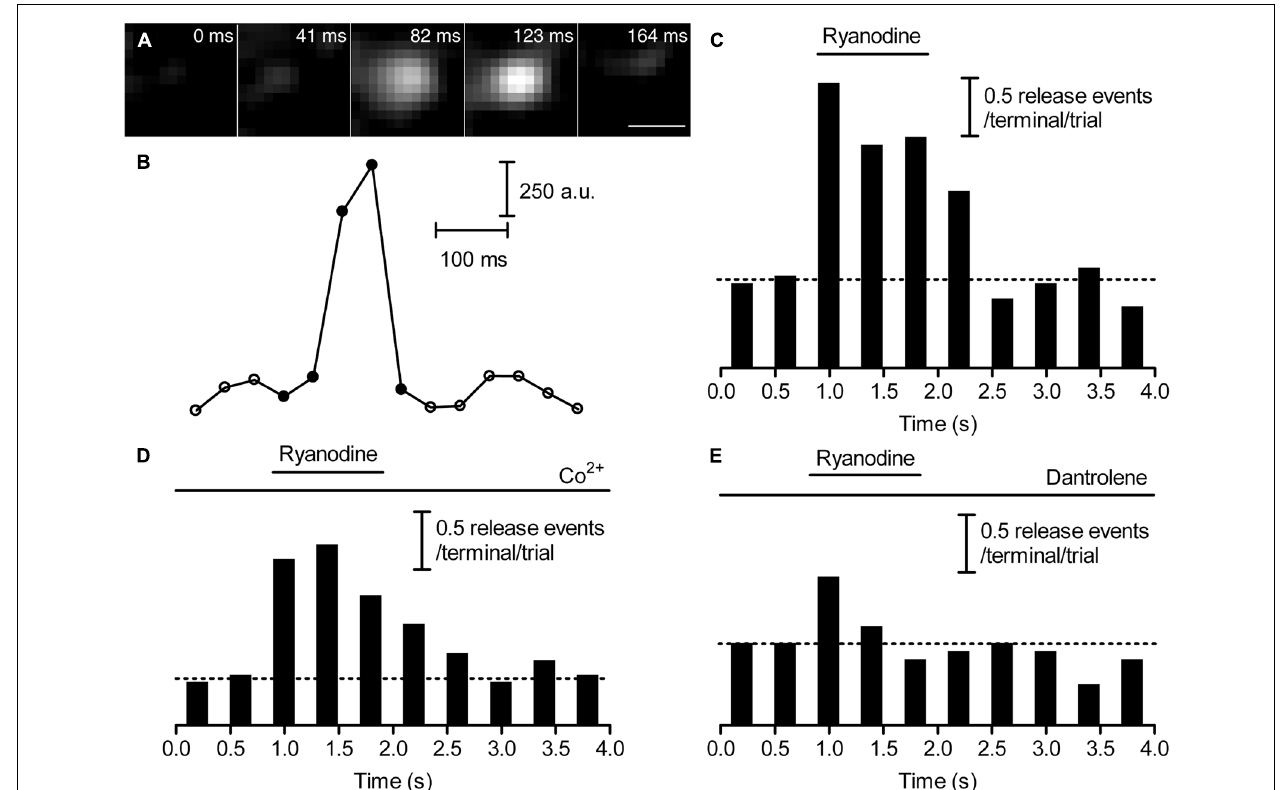
FIGURE 4 | Ca 2 + released from intracellular stores is capable of triggering release. (A) Sequential images show a pHrodo-loaded vesicle brightening as it approached the membrane and then disappearing due to fusion, following stimulation with a puff of ryanodine (10 μ M). Scale bar: 500 nm. (B) Changes in fluorescence intensity within a 560-nm diameter region of interest placed over this vesicle are plotted against time in (B) . Filled circles indicate the fluorescence intensities of the five frames shown in (A) . To plot release kinetics in panels (C–E) , we counted the number of synaptic vesicle release events per rod terminal